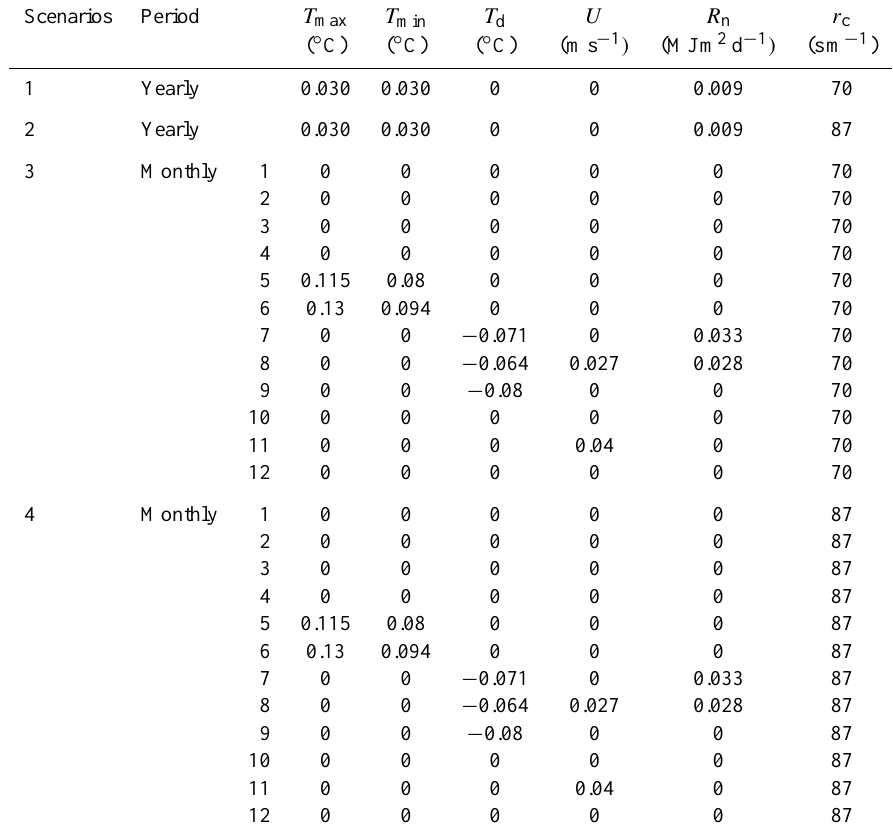
Table 2. Scenarios generated in the Basin according to the trends of the climate variables obtained in Table 1. r c surface resistance as a consequence of the CO 2 increase from 372ppm ( r c =70) to 550ppm ( r c =87).